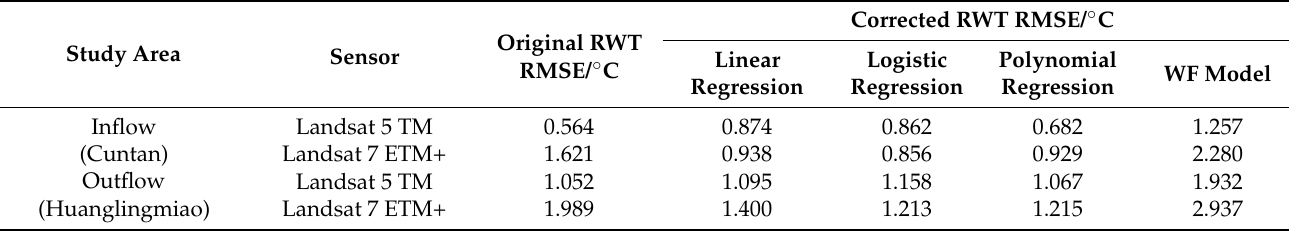
Figure 5. Comparison of the original and logistic-corrected RWT: ( a ) inflow (Cuntan) and ( b ) outflow (Huanglingmiao) derived from Landsat 7 ETM+ ranging from 2004 to 2006 and 2012 to 2016. Table 1. The root-mean-square error (RMSE) for original and corrected river water temperature (RWT) within two study areas for Landsat 5 TM and Landsat 7